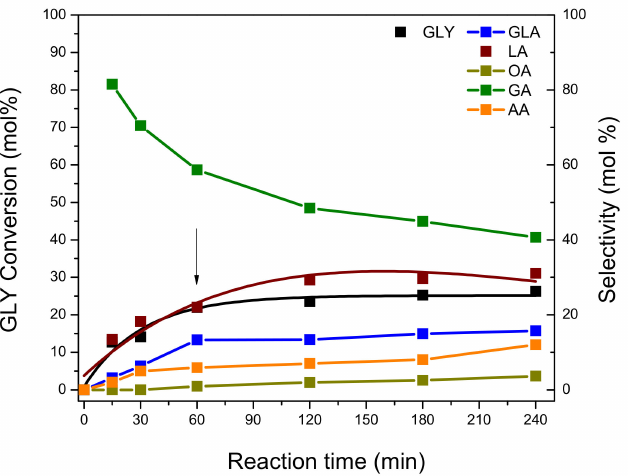
Figure 11. GLY conversion and selectivity to products vs. reaction time with Pt-ZSM-11 catalyst removal from the